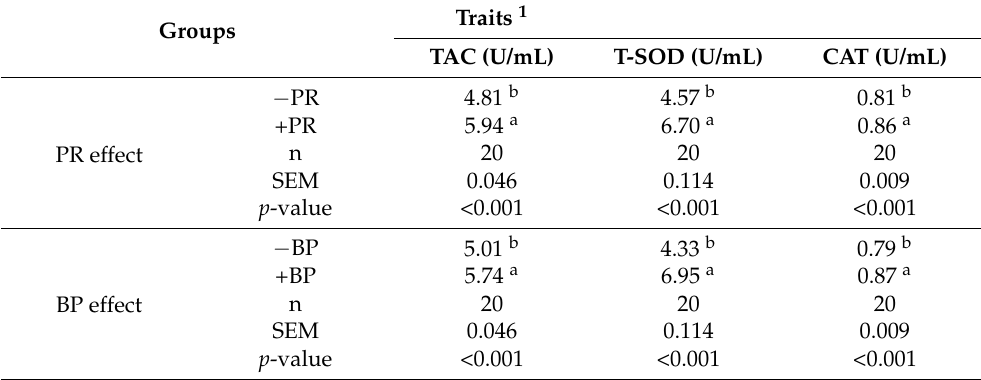
Table 4. Effect of propolis (PR), bee pollen (BP), and their interaction (PR + BP) on the antioxidant indicators of broiler